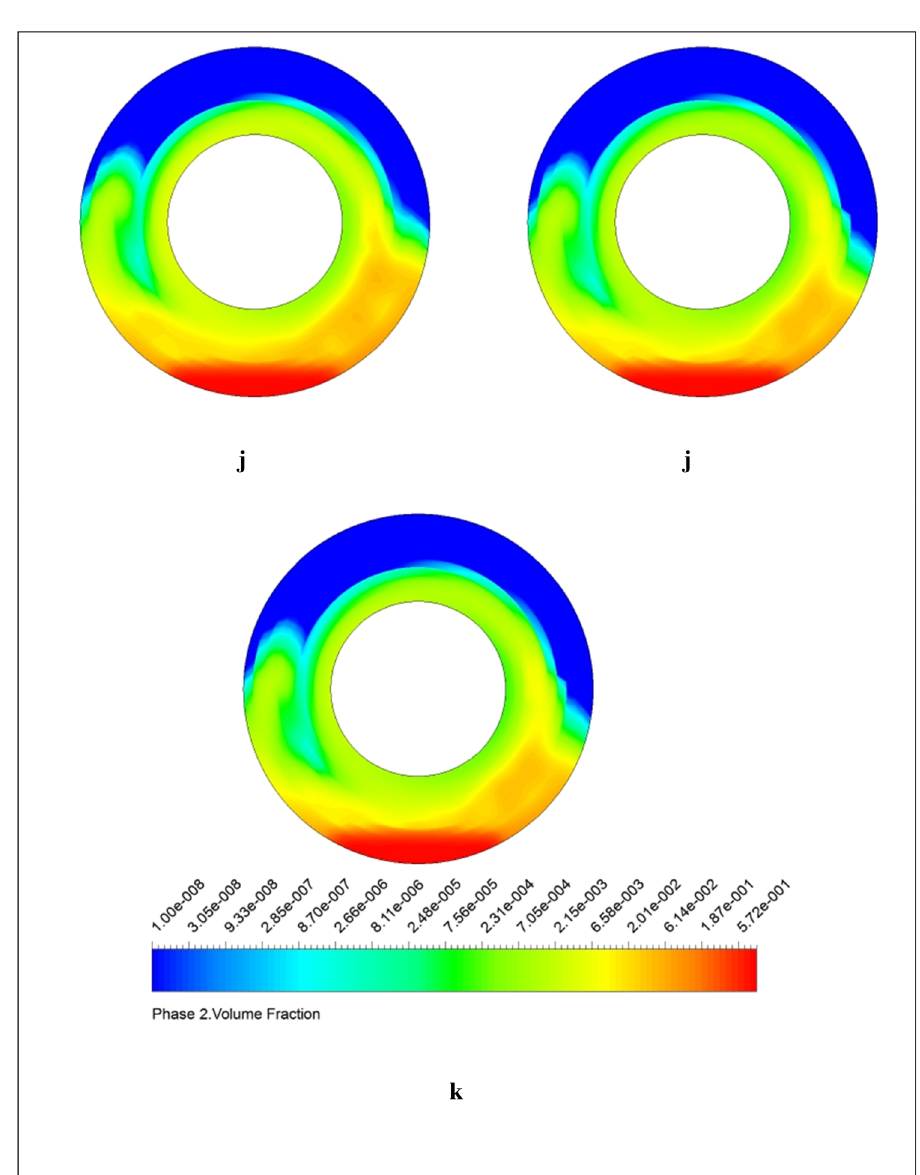
the mud decreases and the fluid behavior will have a greater deviation from a single-phase fluid. In fact, there will be a more dilute fluid present along the path, which reduces the pressure drop. Equation 34 depicts the relationship between pressure drop and cutting density. The correlation coefficient for the equation proposed in this case is greater than 98%, which implies the accuracy of the equation